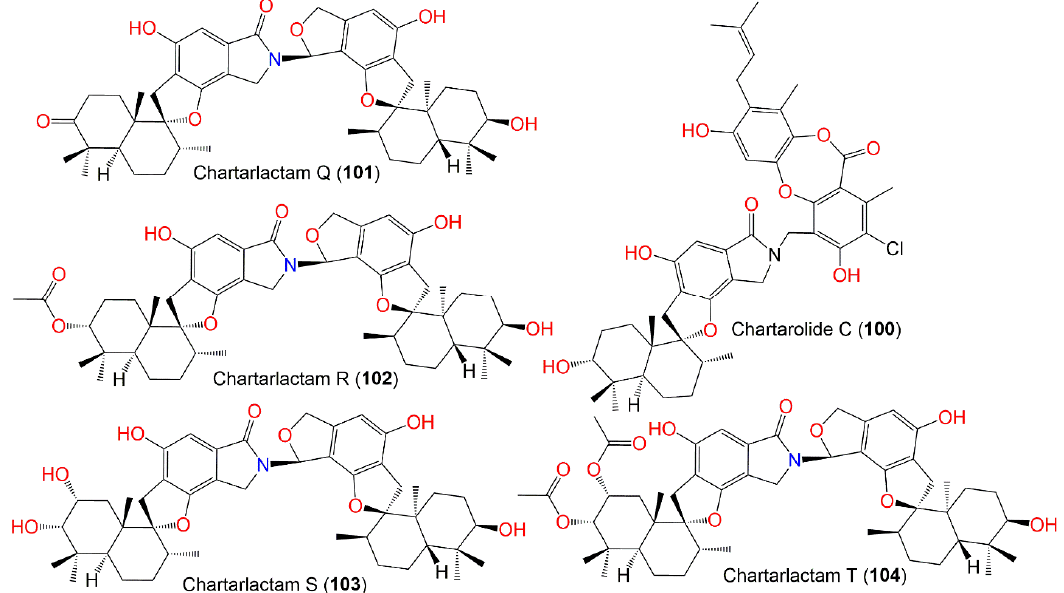
Figure 13. Structures of dimeric phenylspirodrimane derivatives ( 100 – 104 ) reported from S . charta- rum